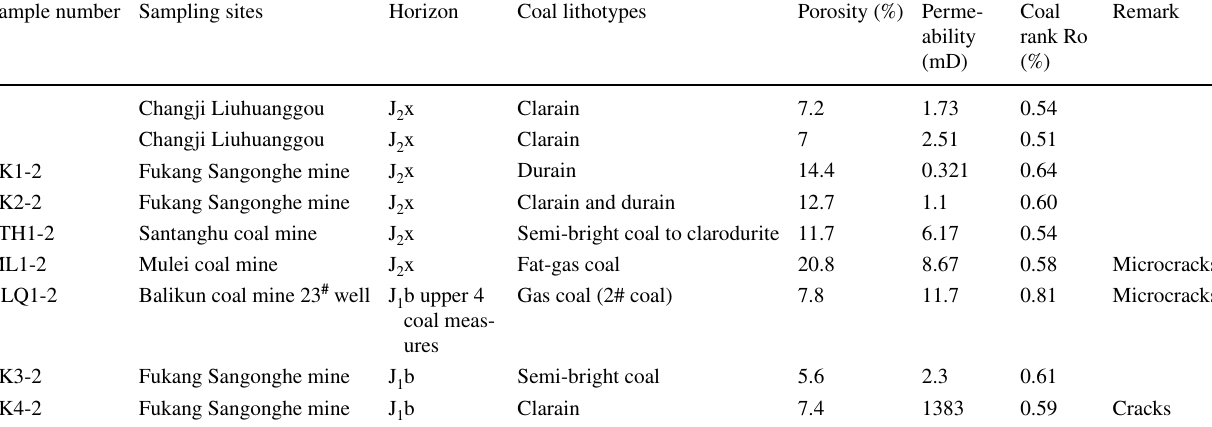
Table 2 Physical property of coal reservoir by porosity–permeability joint tester in Junggar Basin Sample number Sampling